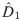
Distance contrast D^1 between a small-world graph and the the degree matched configuration model (null model).